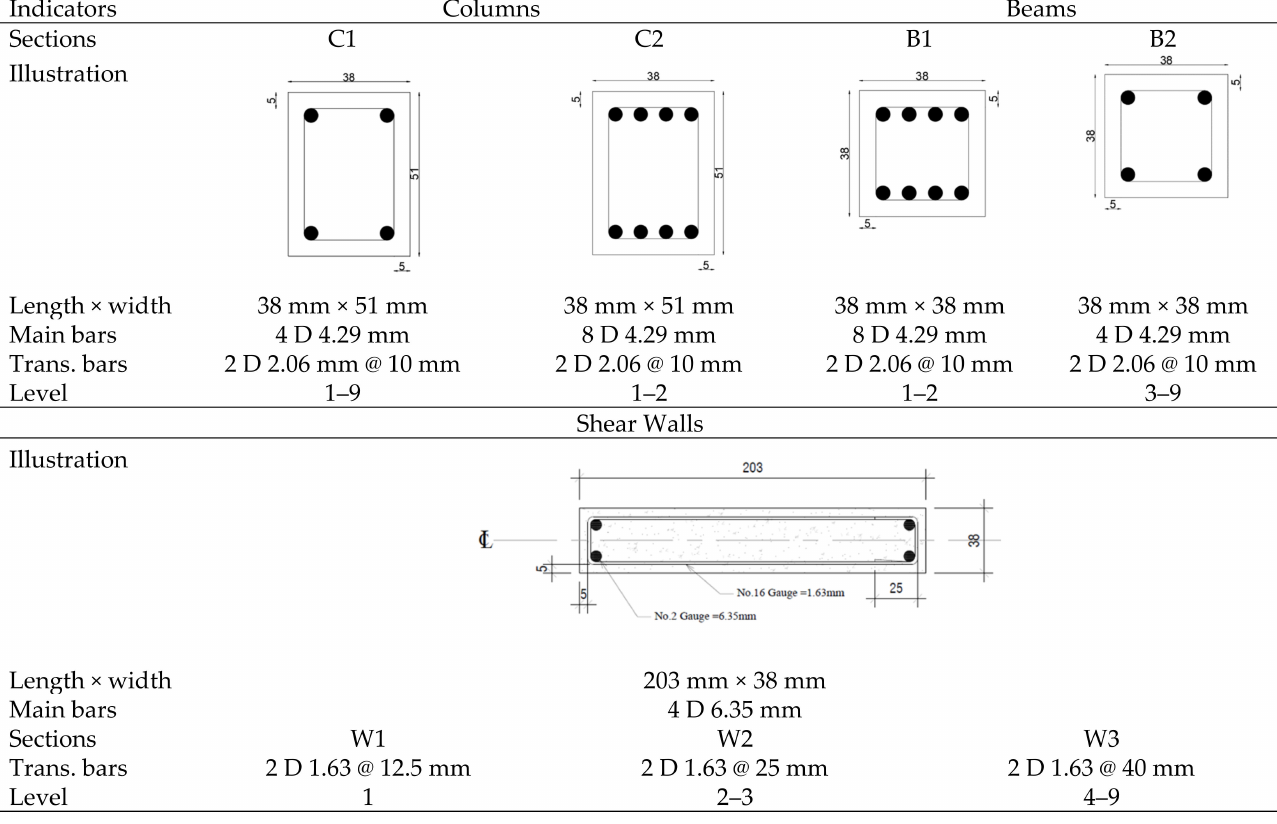
Figure 1. Beam, column, and wall element sections used in experimental tests by Moehle and Sozen (dimension in